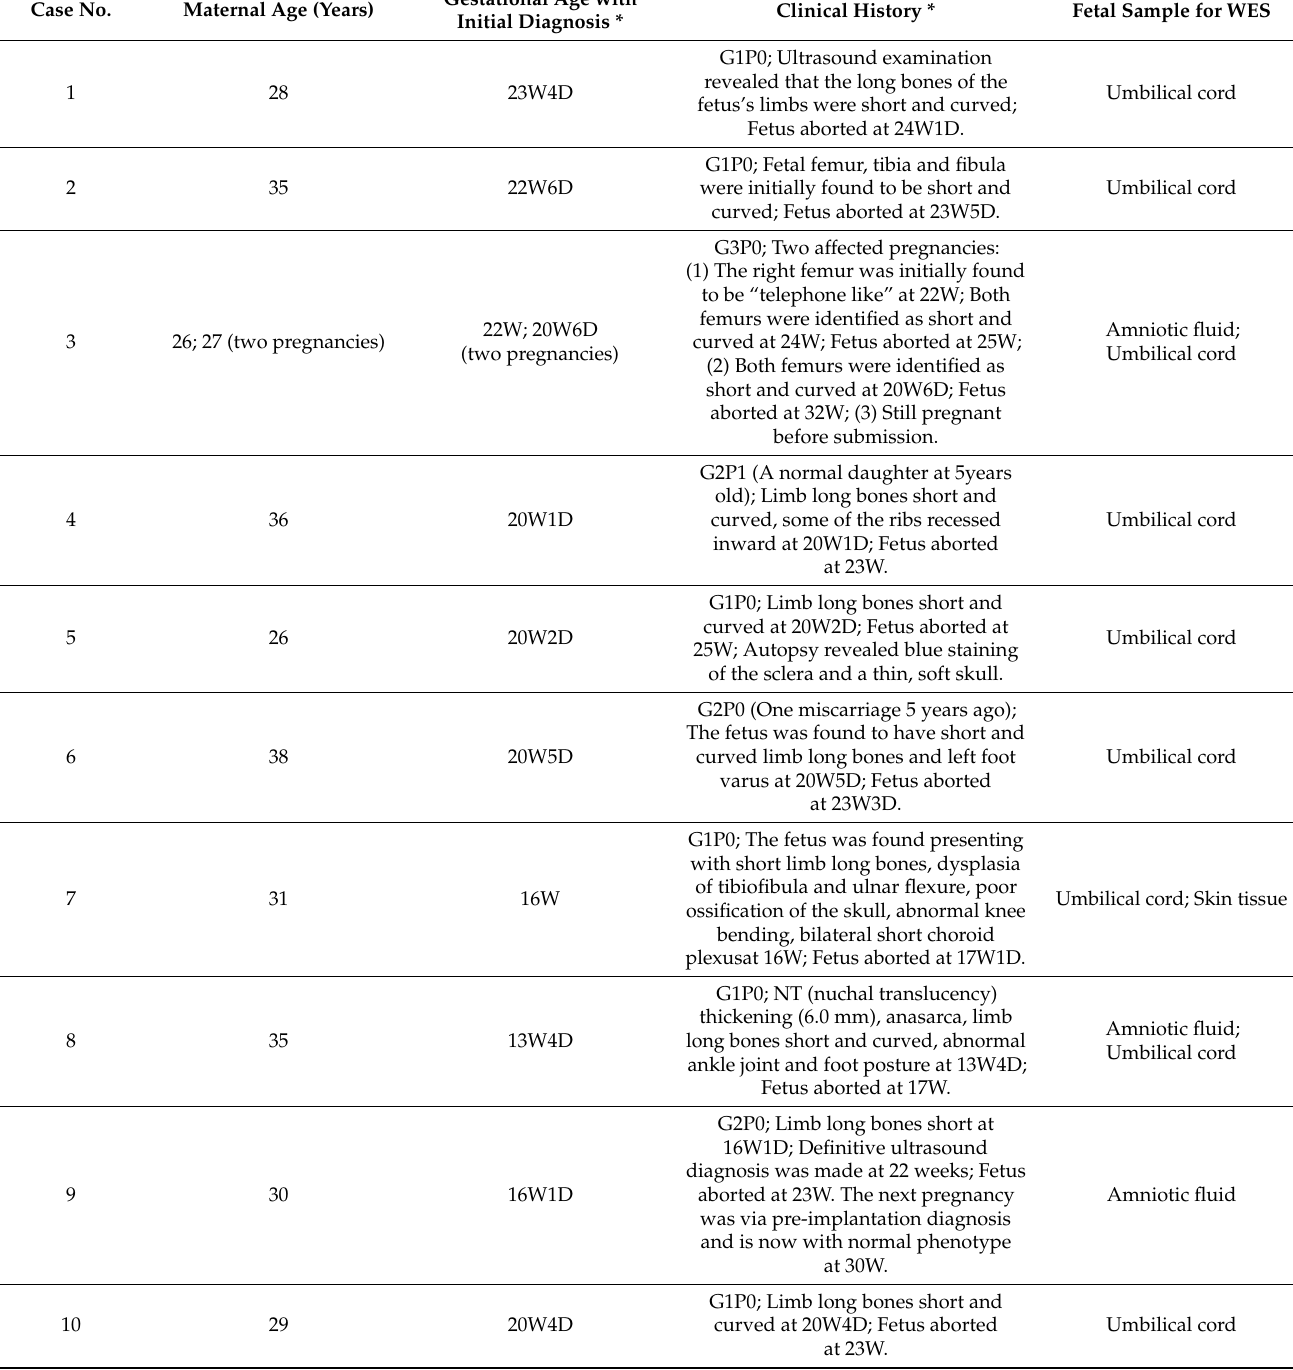
Table 1. Clinical information of the ten recruited